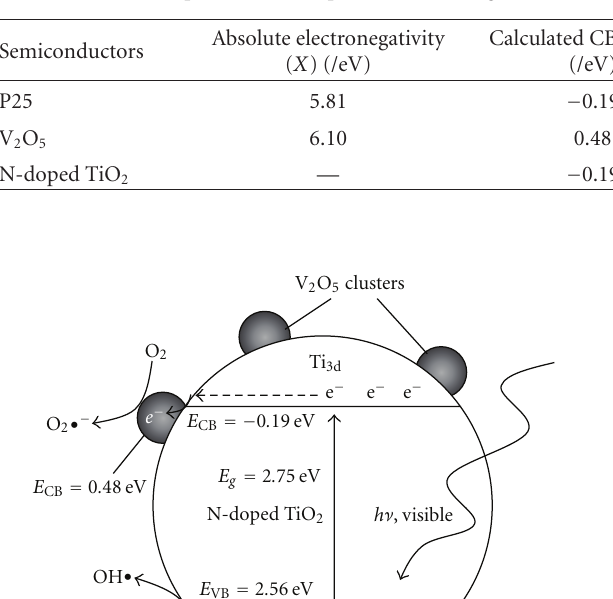
Table 1: Absolute electronegativity, calculated conduction band (CB) edge, calculated valence band (VB) position, and bandgap energy for P25, V 2 O 5 , and N-doped TiO 2 at the point of zero charge.